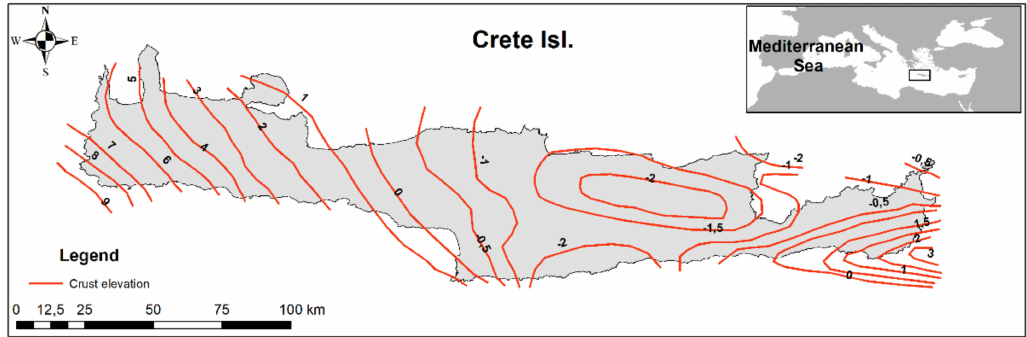
Figure 1. Tectonic uplift as a result of the AD 365 earthquake (modified from